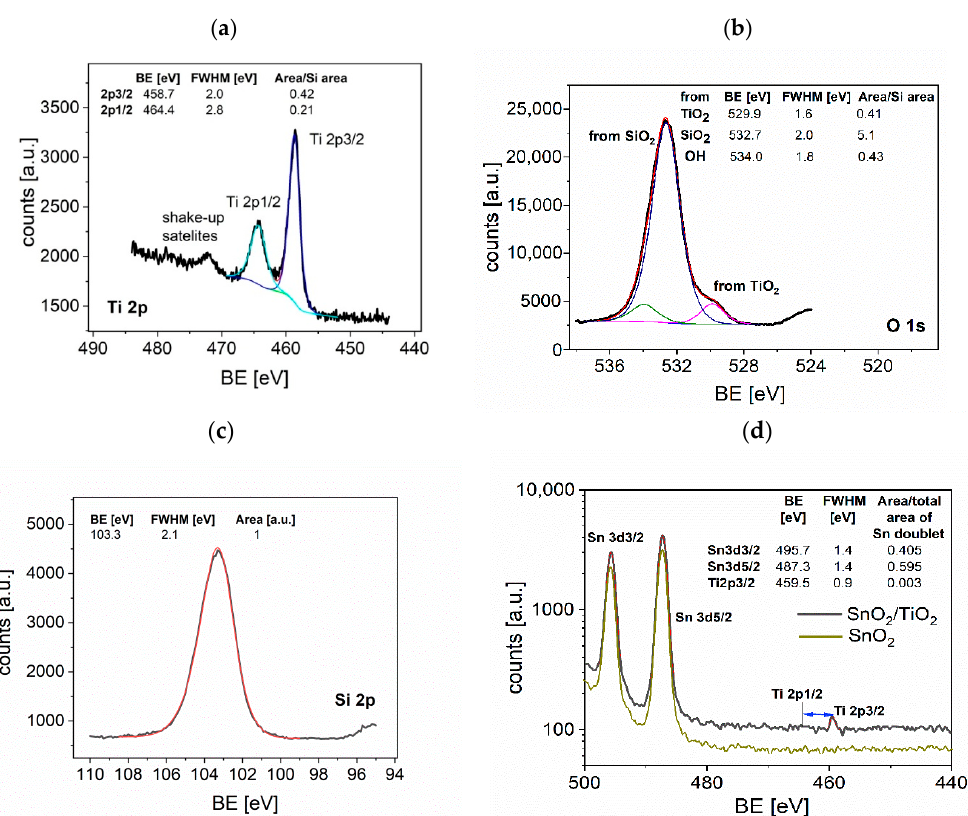
Figure 8. XPS spectra ( a – c ) of TiO 2 thin film deposited on Si substrate by the L–B technique: ( a ) Ti2p, ( b ) O1s, ( c ) Si2p, ( d ) TiO 2 thin film deposited on SnO 2 thin film by L–B technique; BE-binding energy.